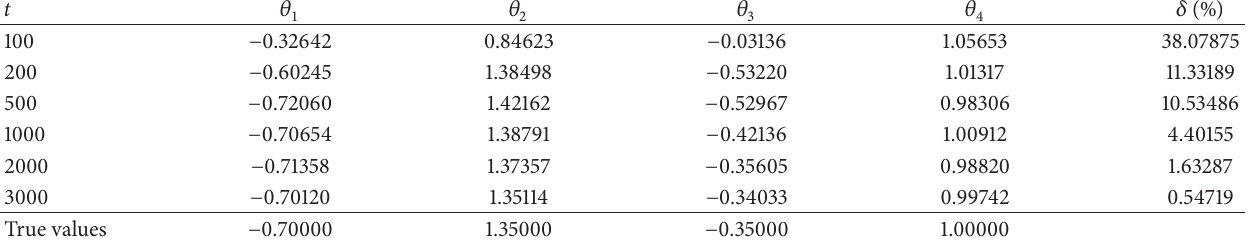
Table 2: The parameter estimates and errors ( 𝜎 2 = 1.00 2 ).